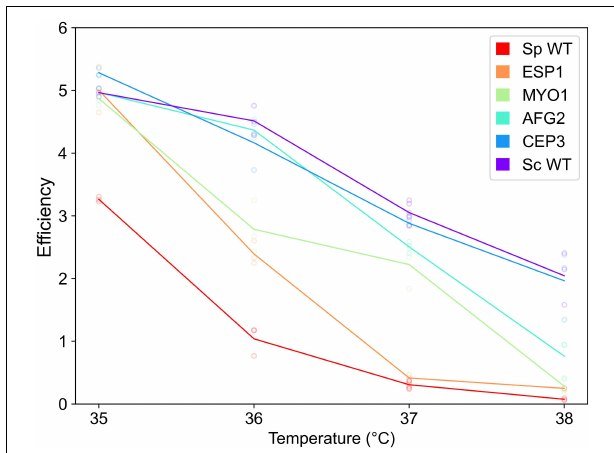
FIGURE 1 | Saccharomyces paradoxus alleles of thermotolerance genes confer temperature-dependent defects in the S. cerevisiae background. Each line reports the results of growth experiments of a strain of S. cerevisiae DBVPG1373 harboring the indicated gene from S. paradoxus Z1, or the respective wild-type parent strains (WT), across a temperature gradient. The y -axis reports growth efficiency, the optical density reached by the culture after 24 h at the temperature indicated on the x -axis, as a difference from the analogous quantity at time zero. Each point reports results from one biological replicate ( n = 3), and the line represents the average growth efficiency of the indicated strain across the temperature gradient. Statistical comparisons across strains are reported in Supplementary Table 2